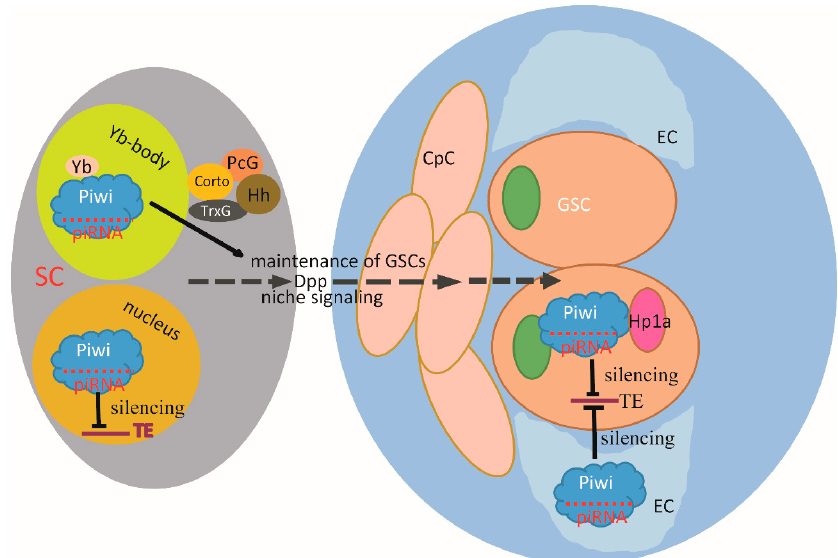
Figure 5. Piwi function in Drosophila GSCs self-renewal. Stem cell self-renewal requires both cell-autonomous and extrinsic signaling mechanisms. Niche signaling pathways involving Yb, Piwi, Dpp and Hh are expressed in SCs for GSC maintenance. The chromatin factor Corto, which is expressed in the niche cells, interacts with Piwi, PcG and TrxG in epigenetic regulation. Piwi also interacts with HP1a for TEs silencing for GSCs self-renewal. Piwi in ECs maintains PGC and GSC germlines and controls GSC lineage differentiation. Dpp: Decapentaplegic; Hh: Hedgehog;